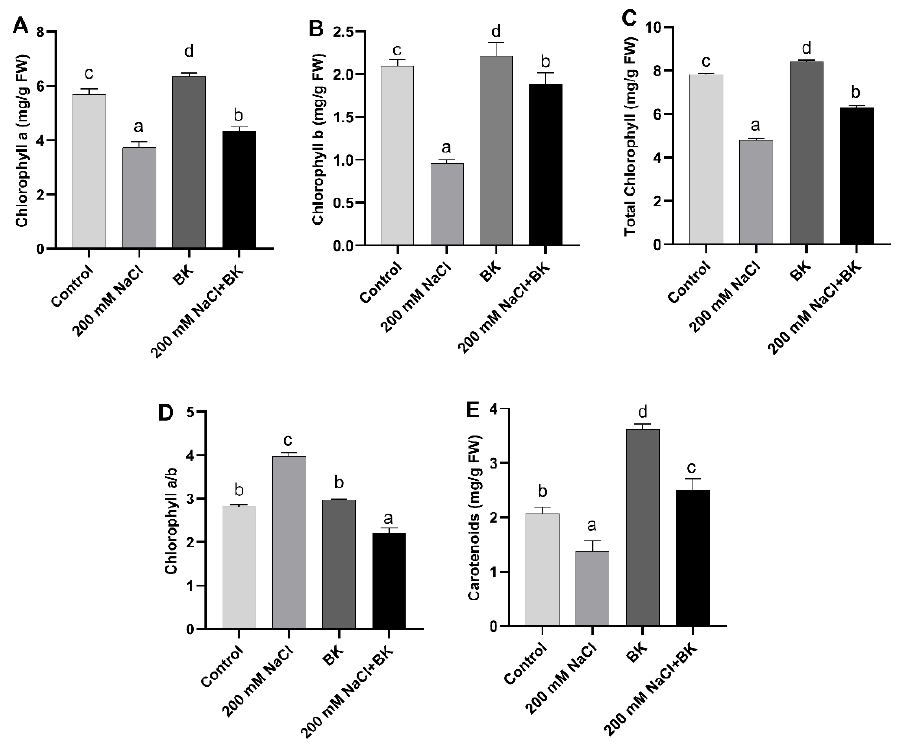
Figure 3. Influence of A. welwitschiae BK association on photosynthetic pigments. ( A ) Chlorophyll a, ( B ) chlorophyll b, ( C ) total chlorophyll, ( D ) chlorophyll a/b ratio, and ( E ) carotenoids of maize grown under salt stress. Data represent the means and SE of three independent replicates for each treatment. Significant differences ( p ≤ 0.05) are marked with different le tt ers.